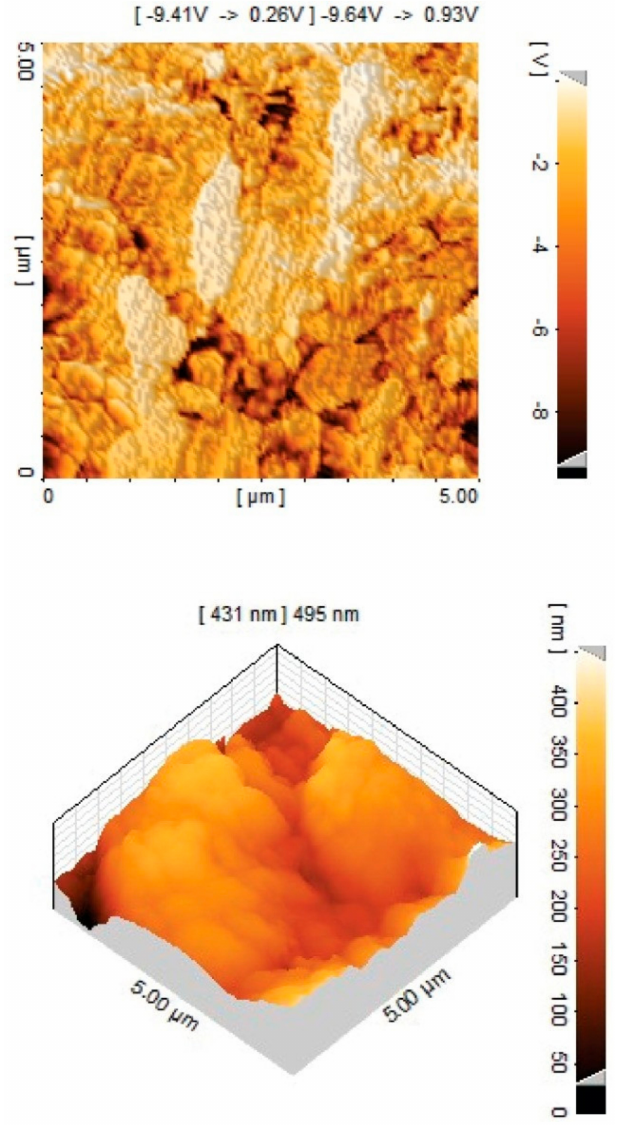
Figure 5. Three-dimensional AFM image of polyurethane sample